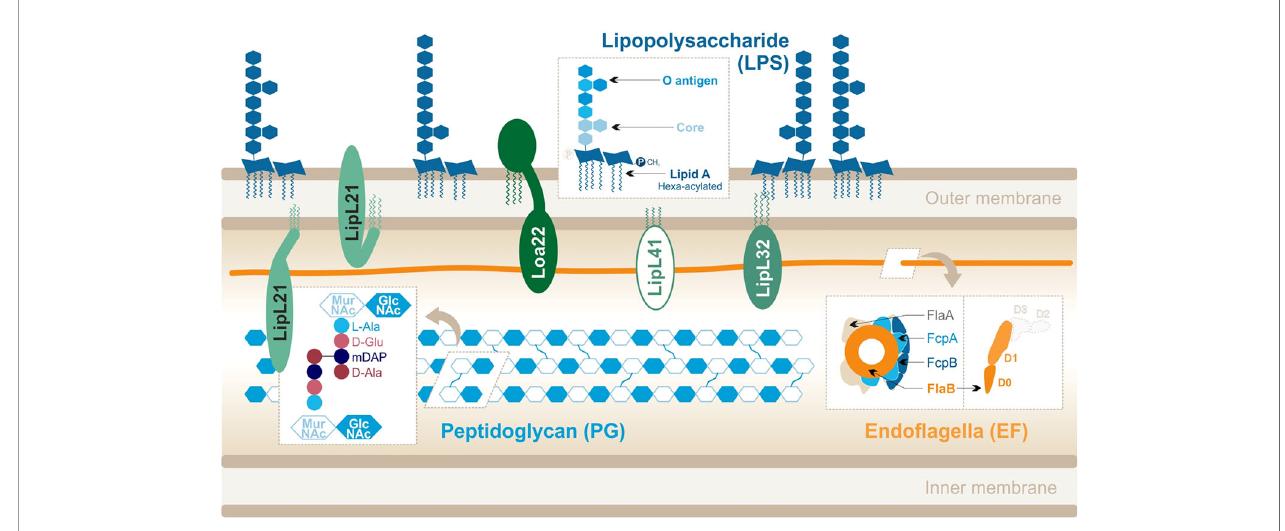
FIGURE 2 | Leptospira interrogans cell wall and MAMPs: peptidoglycan (PG), endo fl agella (EF), abundant lipoproteins and atypical lipopolysaccharide (LPS). Adapted from Que-Gewirth et al. (2004), Haake and Zückert (2015), Ratet et al. (2017), Gibson et al.